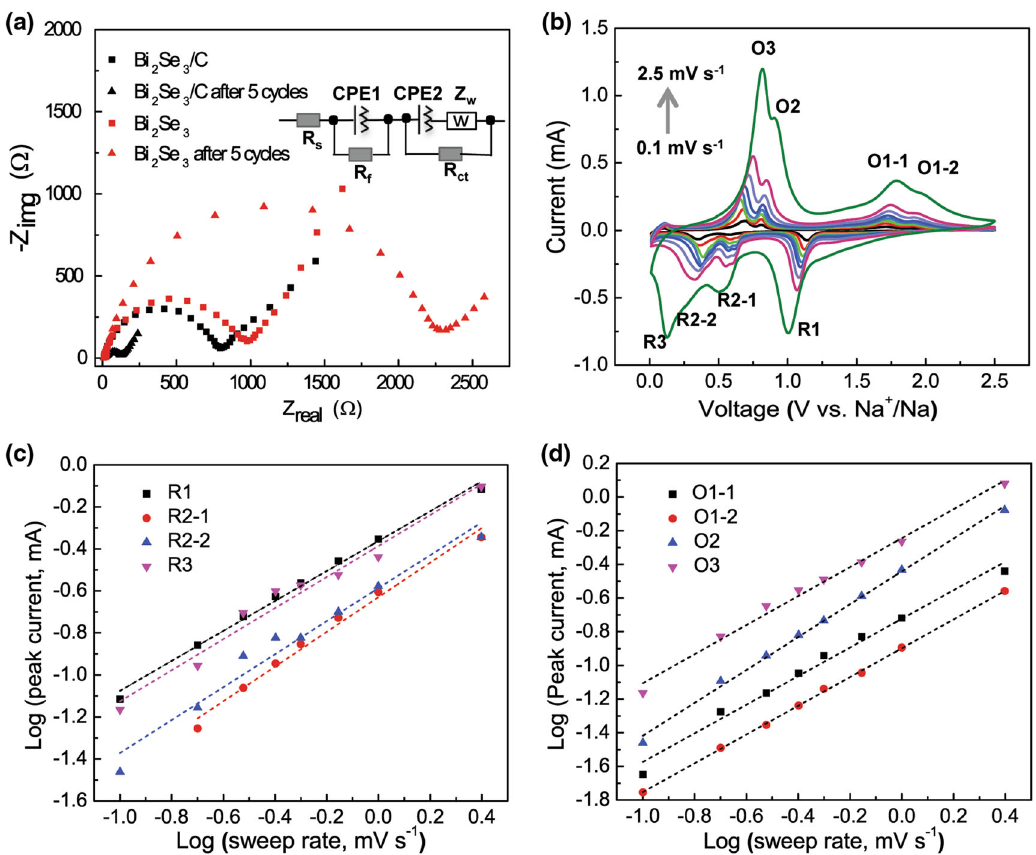
Fig. 5 a EIS spectra for Bi 2 Se 3 and Bi 2 Se 3 /C anodes before and after five cycles. b CV curves of the Bi 2 Se 3 /C anode at different scan rates. c, d b -value fitted by the relationship of the logarithm peak currents and logarithm scan